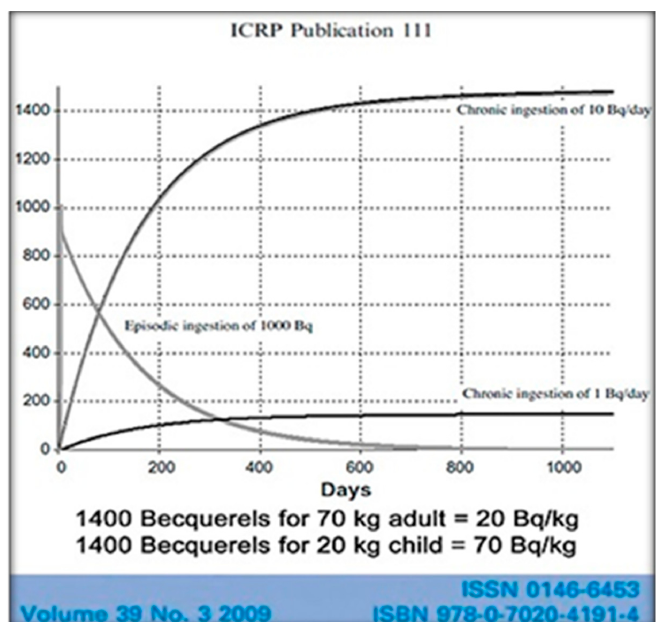
Figure 3. The cumulative biological internal dose (and relative damage) is well represented by the attached graph, where the child is more affected and damaged than the adult